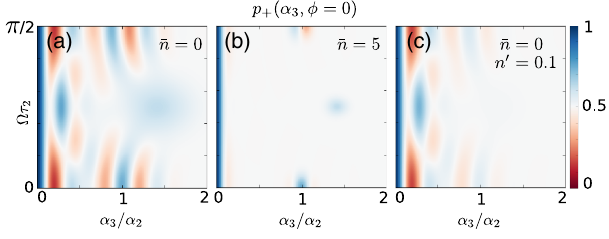
FIG. 6. The probability to find the qubit in its excited state, p ð α 3 Þ , can be used to probe different wave-number components þ in the position probability distribution P ð x Þ . As the resonator evolves (increasing Ω τ 2 ), different wave numbers are present in P ð x Þ (see Fig. 5). The probability p ð α 3 Þ is plotted for the þ resonator initially in (a) a pure state, (b) a thermal state of ¯ n ¼ 5 phonons, and (c) a pure state, but with decoherence (represented by n 0 added phonons) after the second